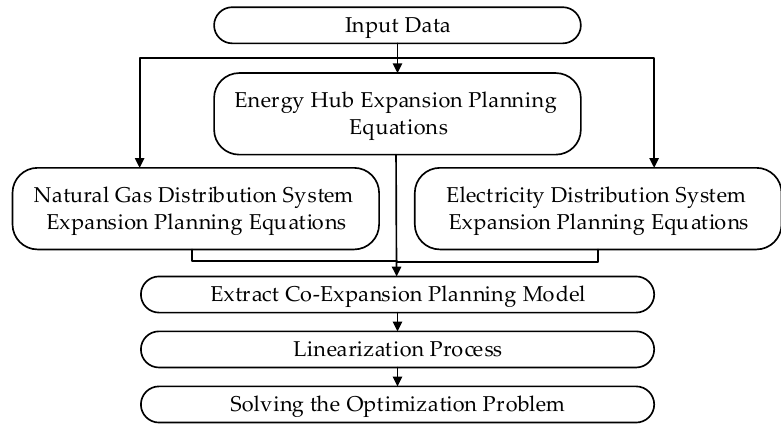
Figure 1. The proposed co-expansion planning framework.